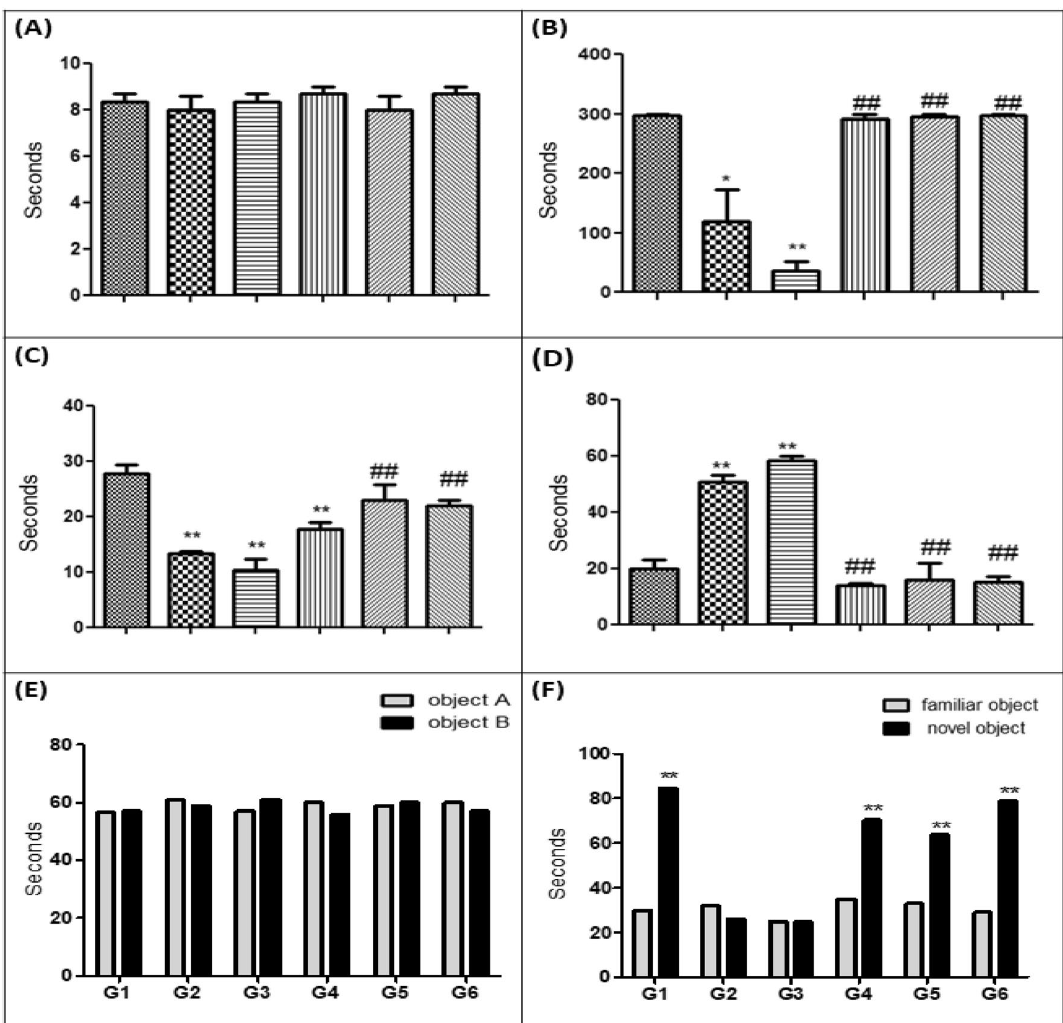
Figure 1. Analysis of behavioral tests: ( A ) Effect of ivabradine on time taken to enter the dark compartment in passive avoidance test in the first day which presented as IL in scopolamine induced dementia (in seconds). ( B ) Effect of ivabradine on time taken to enter the dark compartment in passive avoidance test which presented as STL in scopolamine induced dementia (in seconds). PA passive avoidance, IL initial latency, STL step-through latency. ( C ) Effect of ivabradine on time spent on the target quadrant where the platform was located during the probe trial in seconds in scopolamine induced dementia. ( D ) Effect of ivabradine on time taken to locate the position of the platform is presented as escape latency during the probe trial in seconds in scopolamine induced dementia (in seconds). ( A – C ) Data have been analyzed by using one way ANOVA p < 0.01. ( E ) The effect of ivabradine on the time spent exploring objects in the sample phase in scopolamine induced dementia in seconds. Values are analyzed using by two way ANOVA P = 0.8532 and expressed as mean ± SEM. of (8–10) rats. ( F ) The effect of ivabradine on the time spent exploring objects during novel object recognition test in scopolamine induced dementia in seconds. **Highly significant (P > 0.01) difference from familiar object. For all tests values are expressed as mean ± SEM of (8–10) rats. Stars were used for *significant (P > 0.05) and **highly significant (P > 0.01) difference from control group. Other symbols were used for # significant (P > 0.05) and ## highly significant (P > 0.01) difference from dementia control